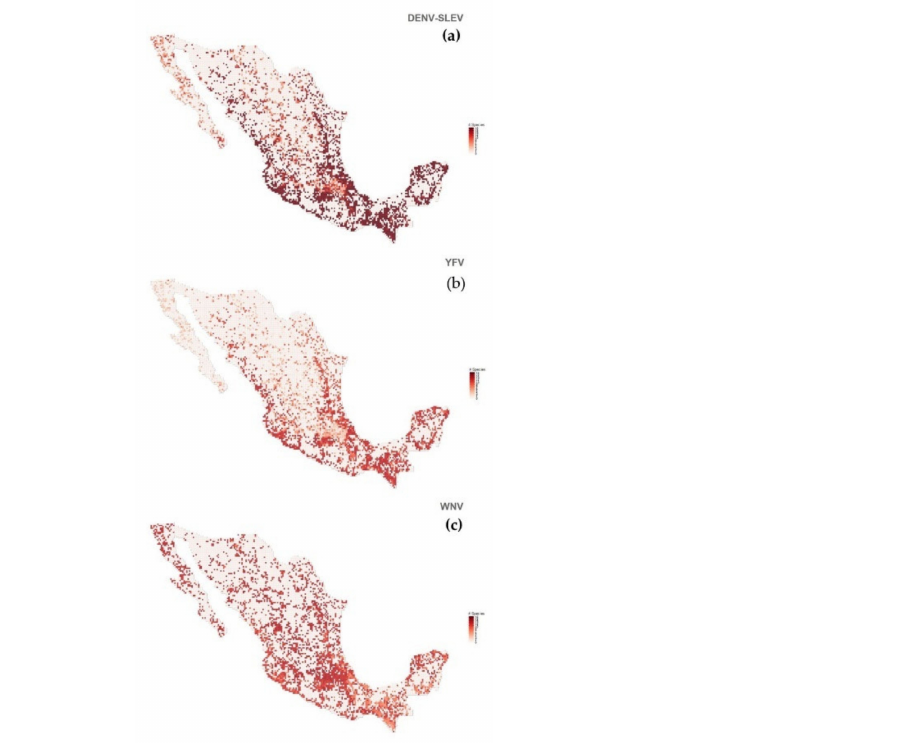
Figure 6. Predicted richness map distributions. ( a ): Dengue virus and St. Louis encephalitis virus